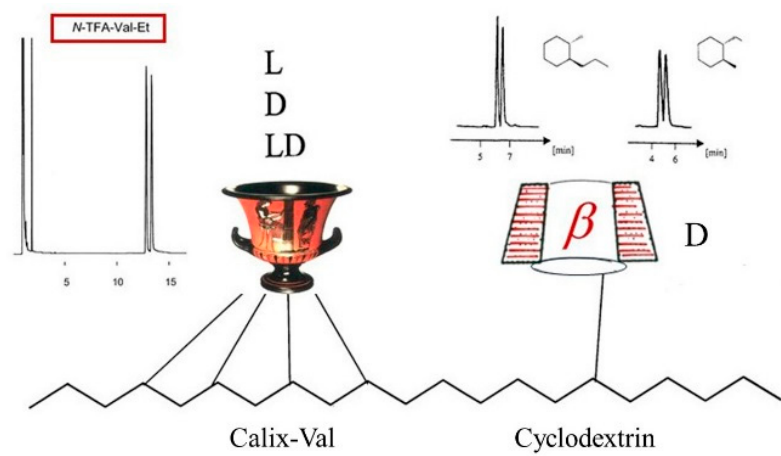
Figure 32. The mixed CSP Chirasil-Calix-Val-Dex.